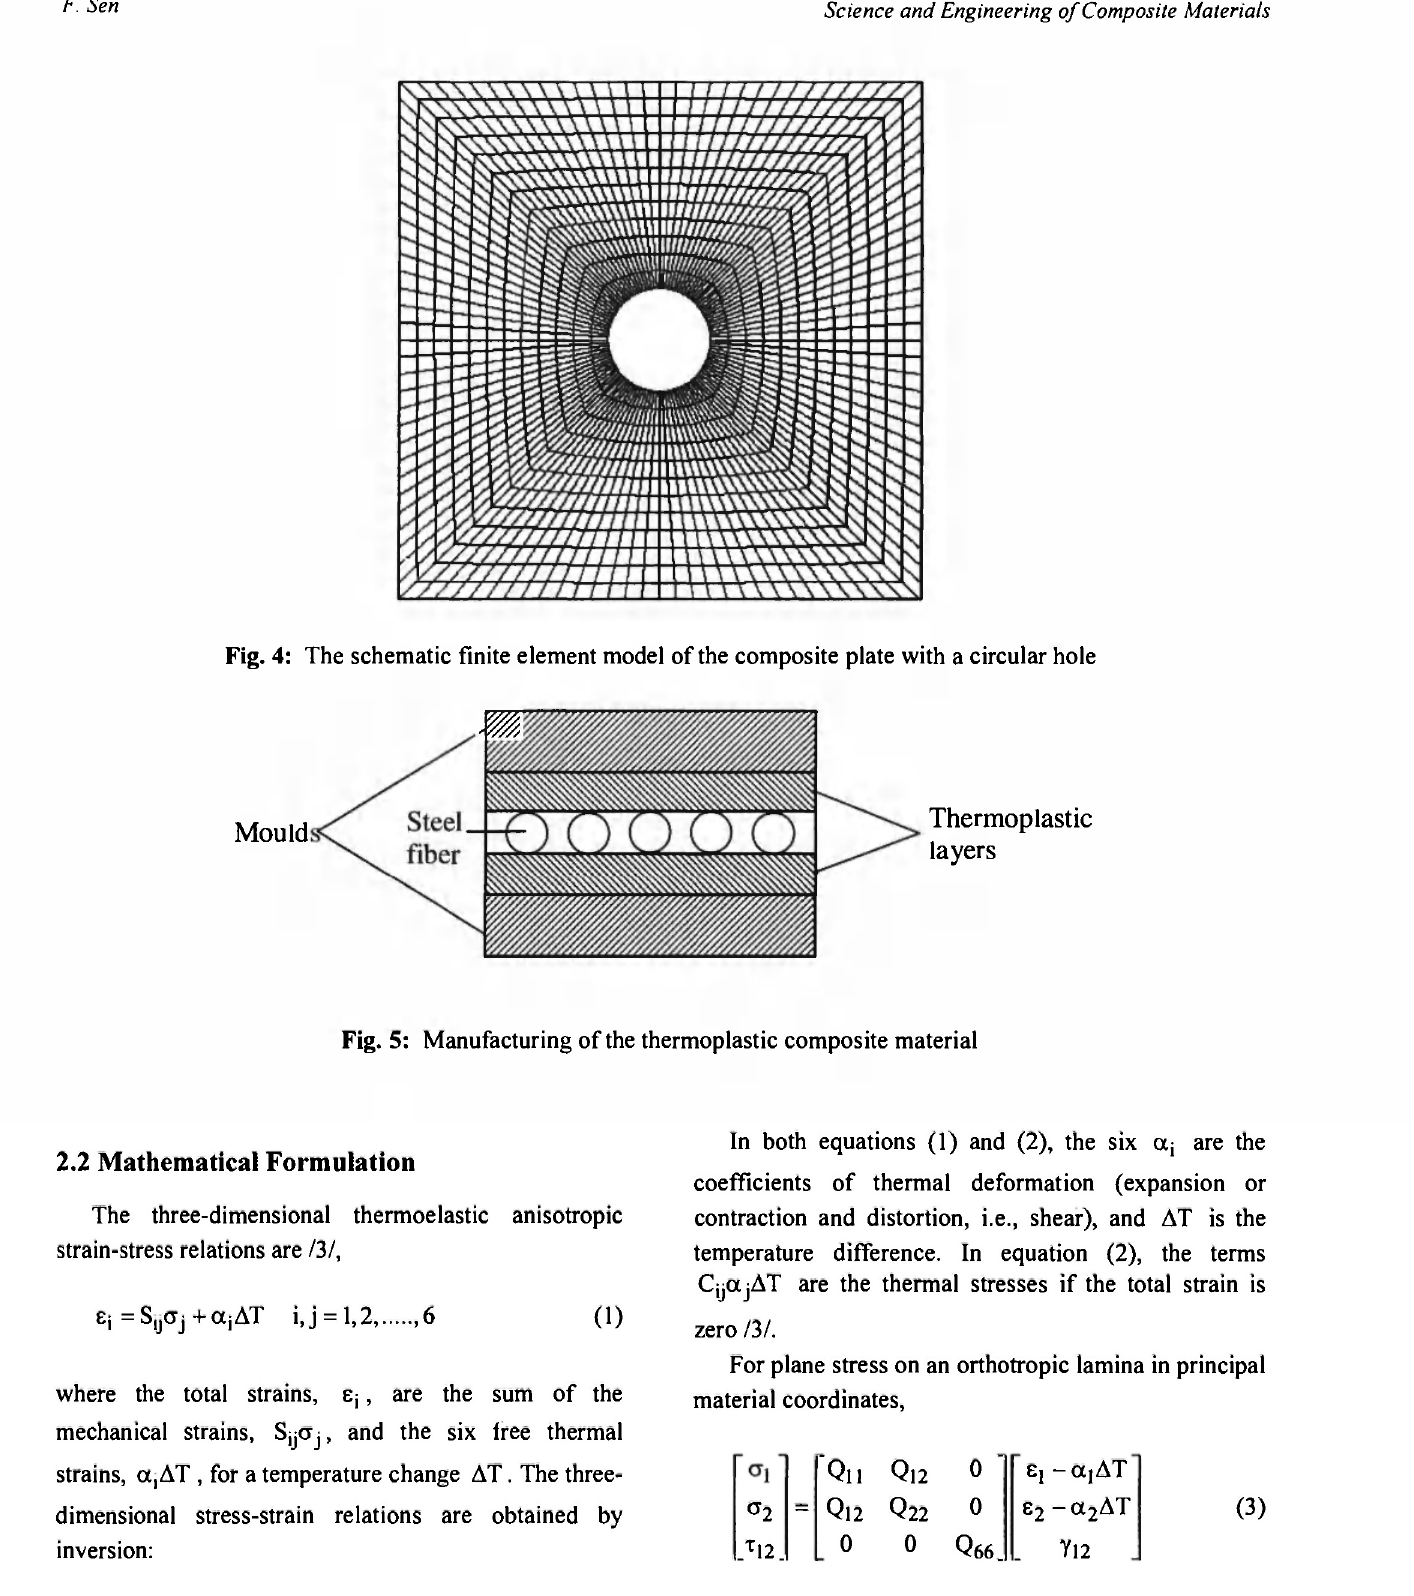
Fig. 5: Manufacturing of the thermoplastic composite